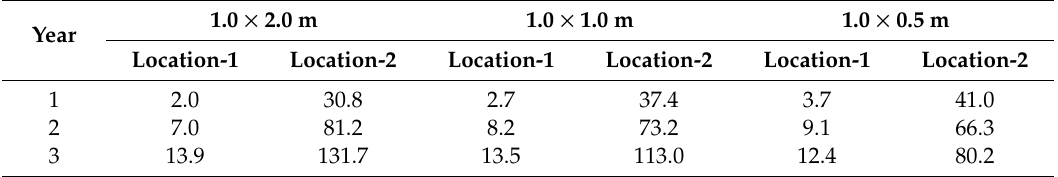
Table 2. Diameter at 30 cm over ground (mm) obtained in temporary plot of short-rotation Gmelina arborea plantations in two di ff erent location in Costa